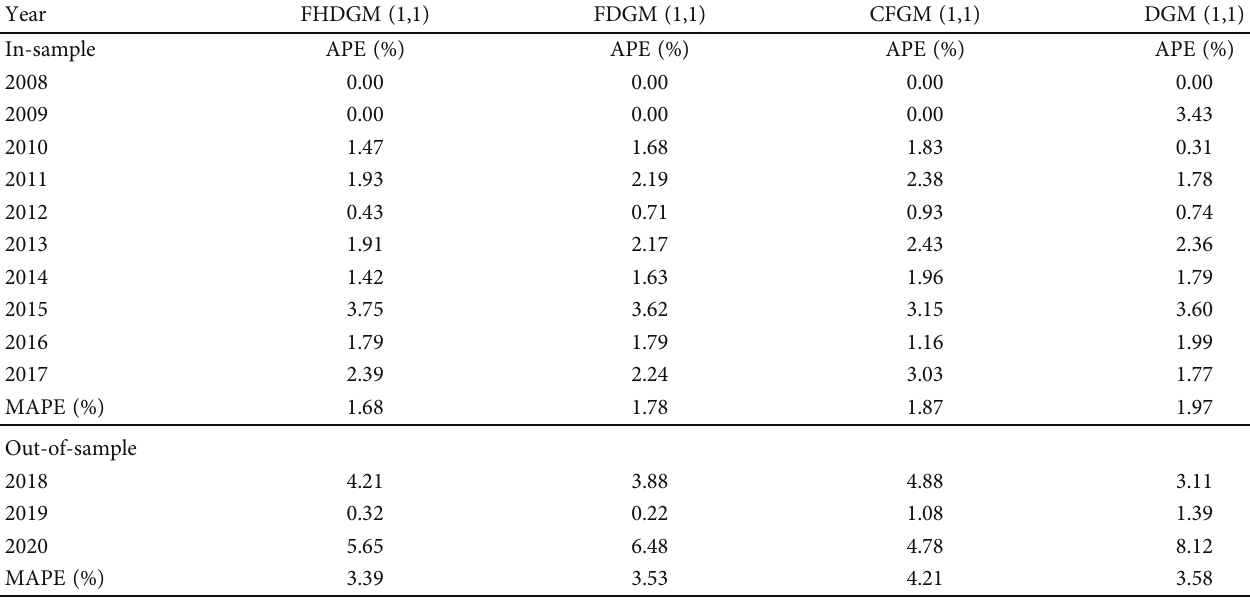
Table 8: The values of APE and MAPE are generated by the above four